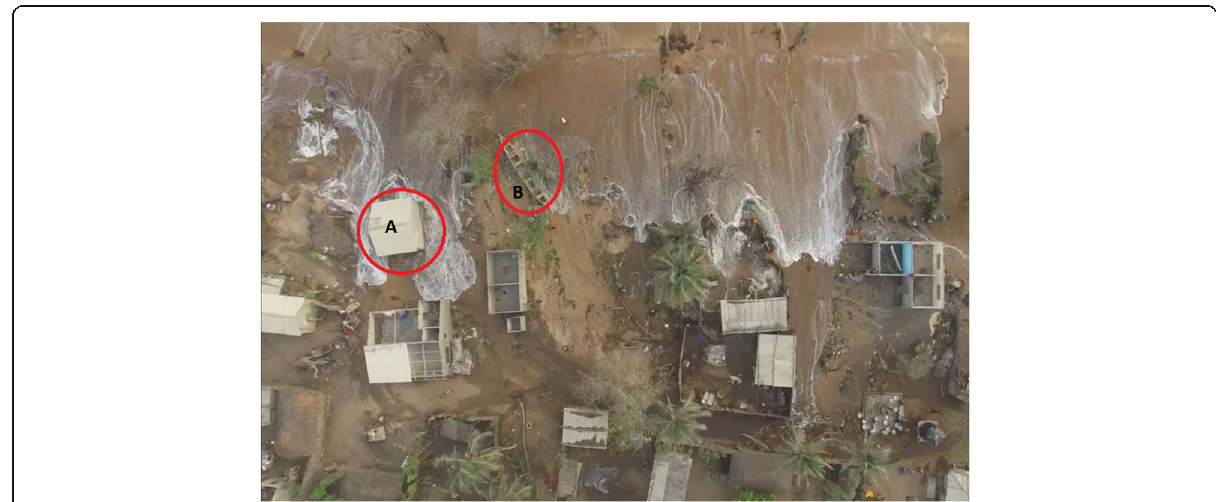
Fig. 9 Flooding in Fuvemeh affecting buildings ( A ) and fishing canoe ( B